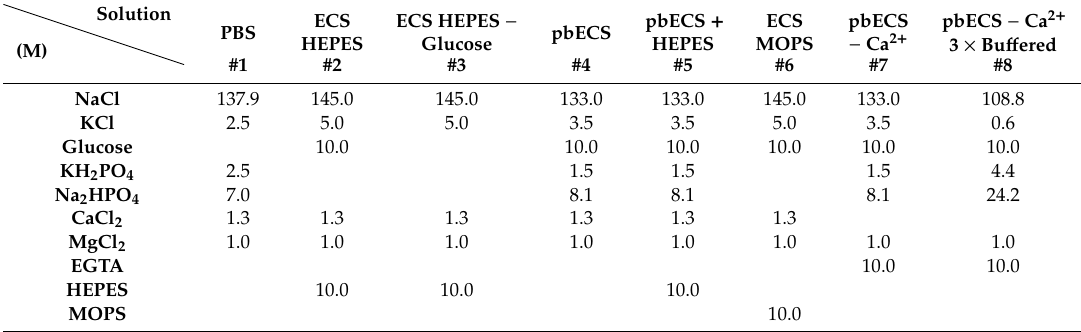
Table 1. Composition of the used solutions with concentrations in mM and an assigned solution number used throughout the